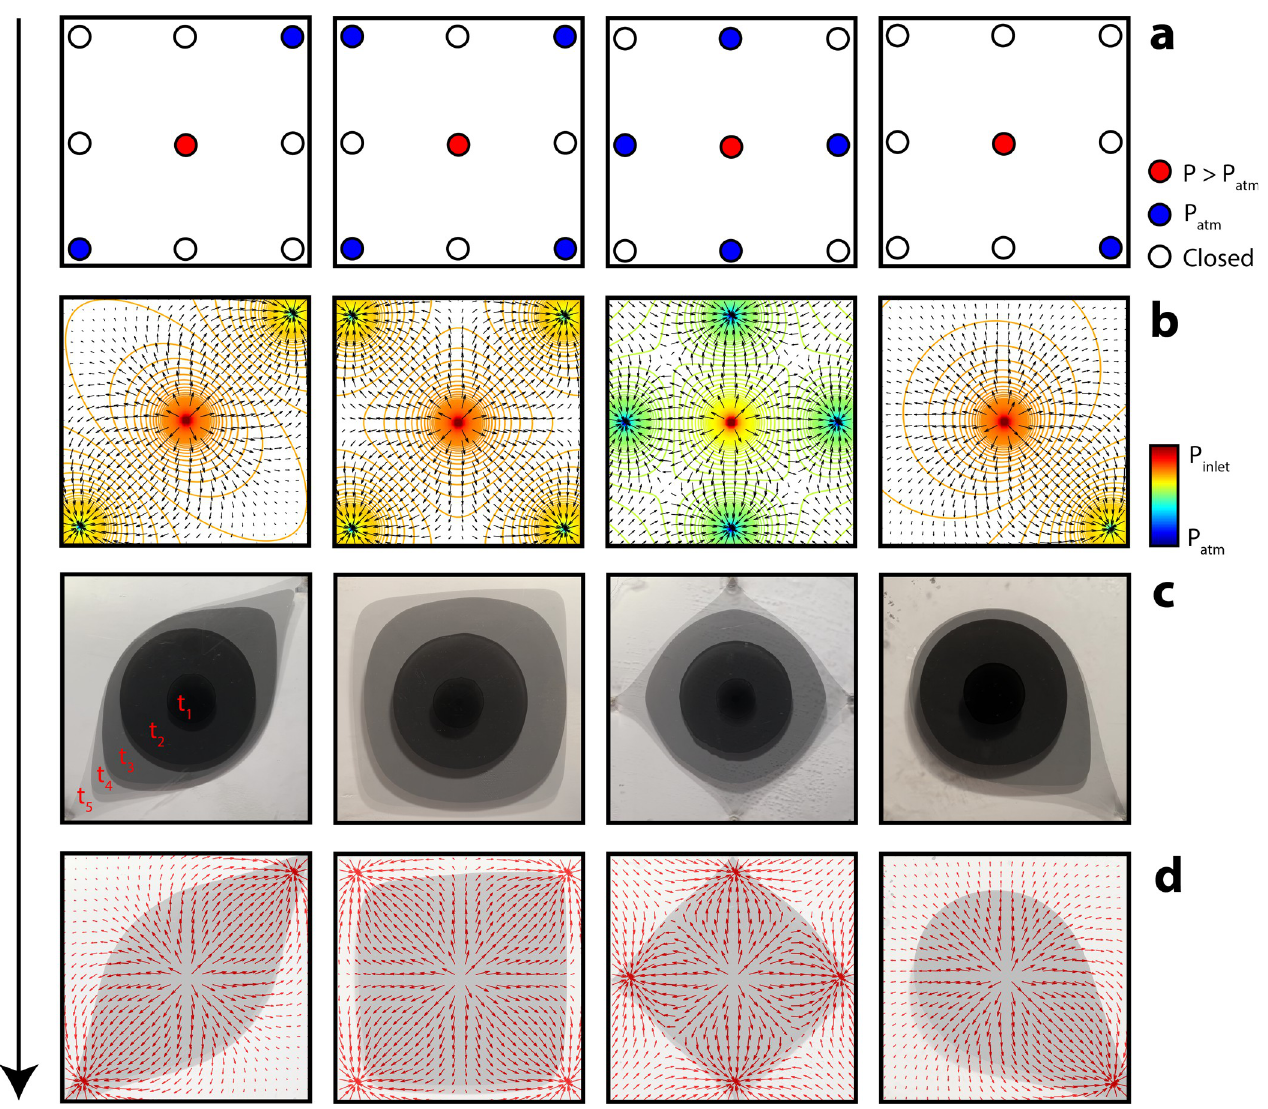
Fig 3. Pigment dispersal across variable anisotropic flow fields. (a) Four Hele-Shaw cell states with spatially-varied outlet boundary conditions. (b) Estimated (idealized) steady-state potential flow field from cell configurations in a. (c) Overlaid time-series images demonstrating anisotropic droplet growth over time. (d) Final droplet configuration from c with overlaid gradient vector field from